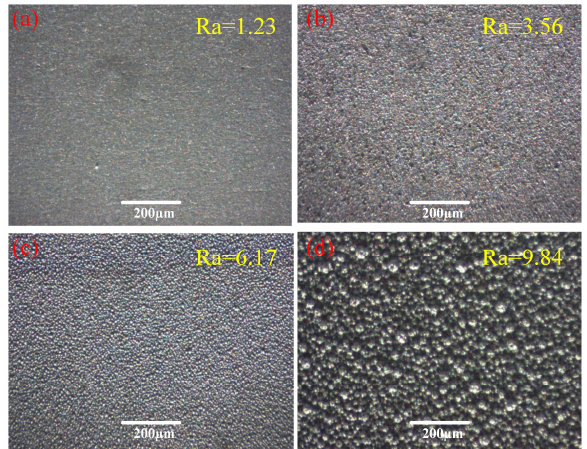
Figure 1. Photos of prepared surfaces obtained in the concentration of 400 g/L at the voltage of 25 V, the relative velocity of 7 m/min and different processing times—( a ) 1 min, ( b ) 3 min, ( c ) 5 min, and ( d ) 7 min.